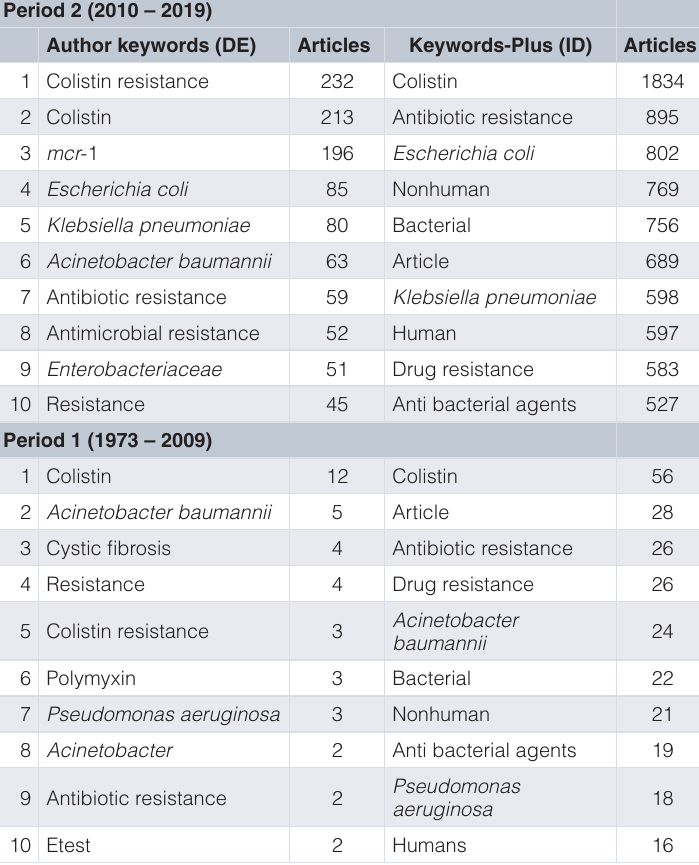
Table 3. Types of keywords observed in period 1 (1973-2009) and period 2 (2010-2019). Period 2 (2010 –